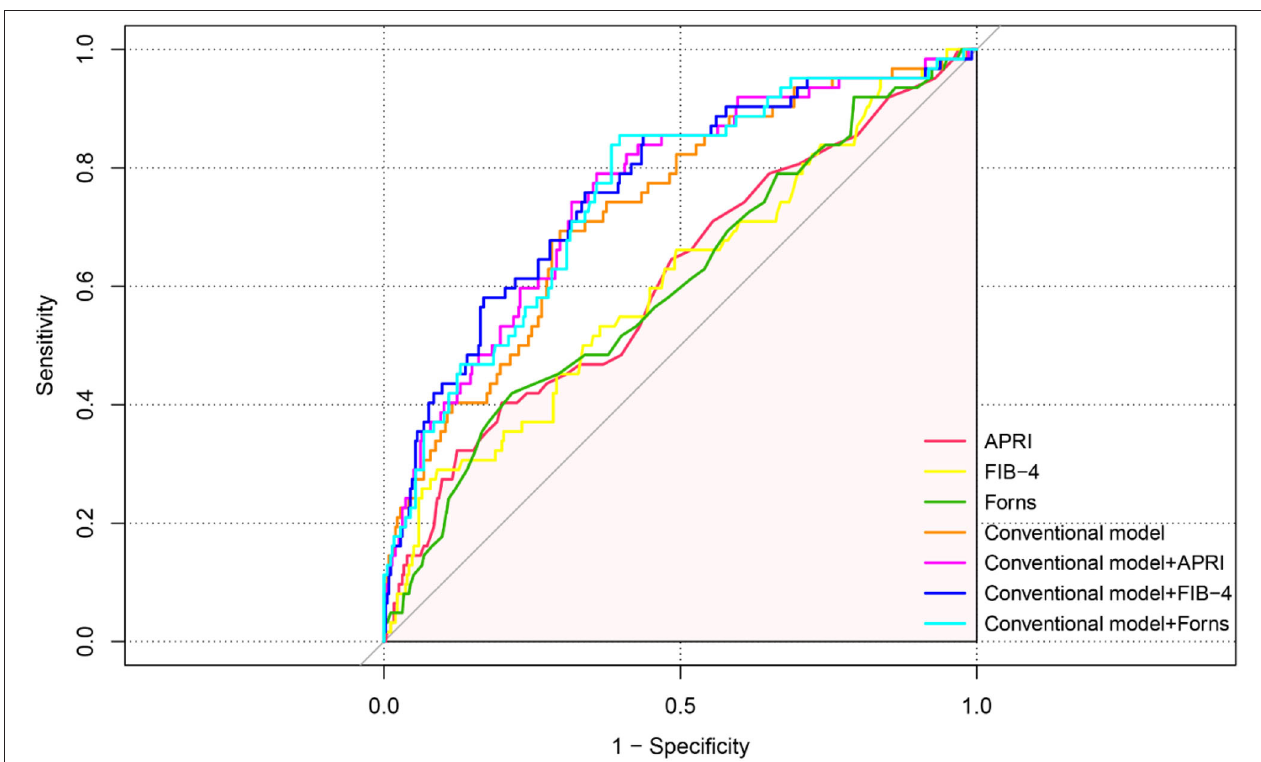
FIGURE 4 | ROC curve analysis of liver fibrosis scores for predicting recurrence in patients with CSDH.